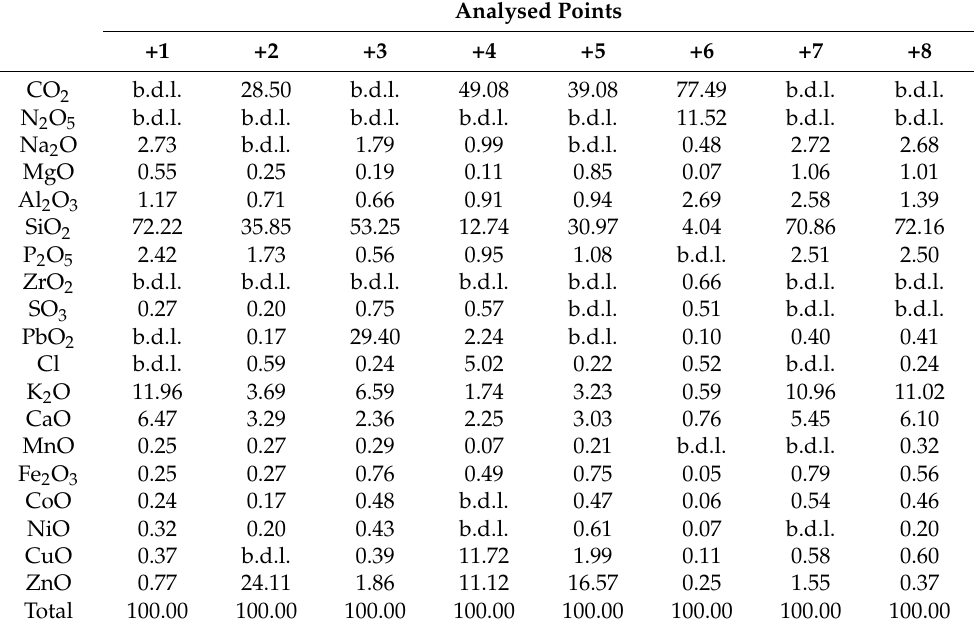
Table 3. Chemical composition, in weight percentage, of the underside of the blue bead. For all elements (except anion Cl) the composition is expressed as oxides weight %. The exact positions of the analysed points are shown in Figure